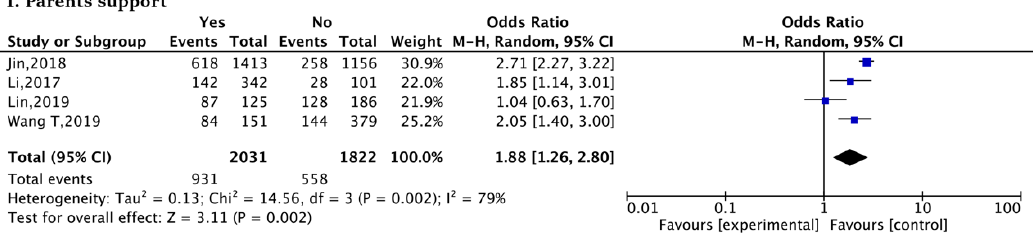
Figure 6. Forest plots of parents or others factors.